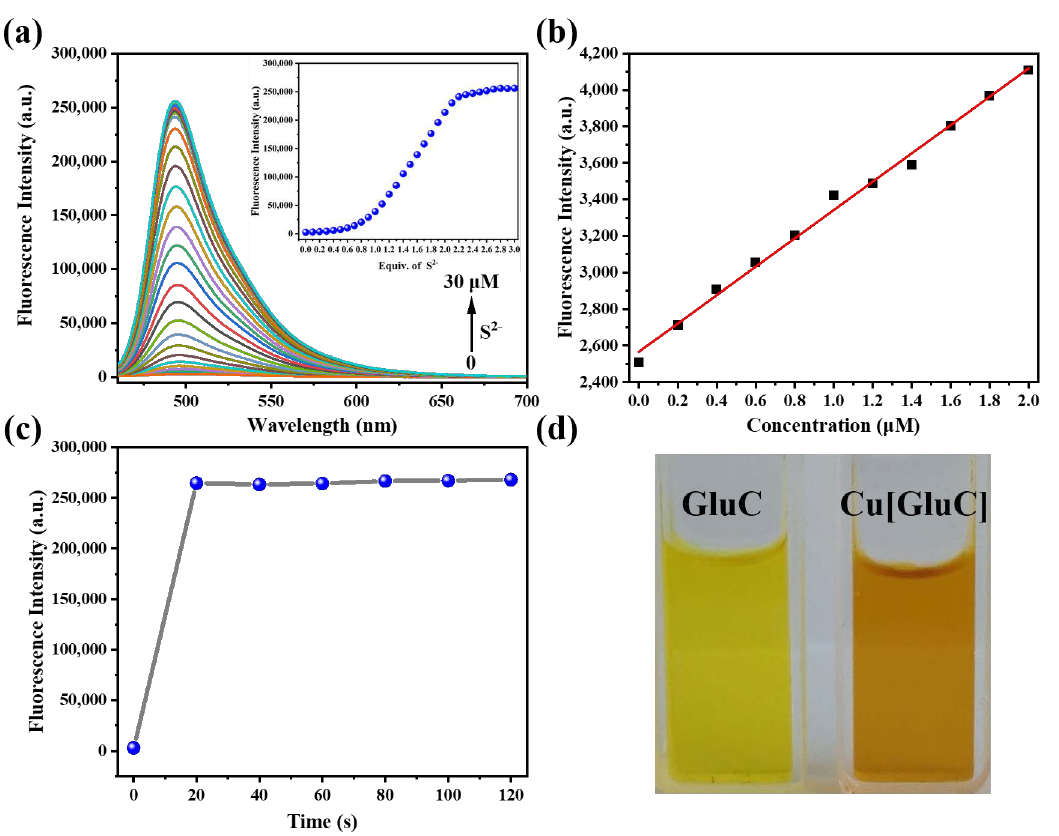
Figure 2. ( a ) The fluorescence spectra titration of Cu[GluC] (10.0 µ M) with increasing concentrations of S 2 − in aqueous solution. Inset: Fluorescence intensity changes of Cu[GluC] at 494 nm with the increasing of S 2 − concentrations − ; ( b ) The linear relationship of the fluorescent intensity (494 nm) of Cu[GluC] (10 µ M) relative to the concentrations of S 2 − in aqueous solution; ( c ) The fluorescence variation process (494 nm) of Cu[GluC] after adding S 2 − in aqueous solution within 120 s; ( d ) The aqueous solution of Cu[GluC] and GluC under visible